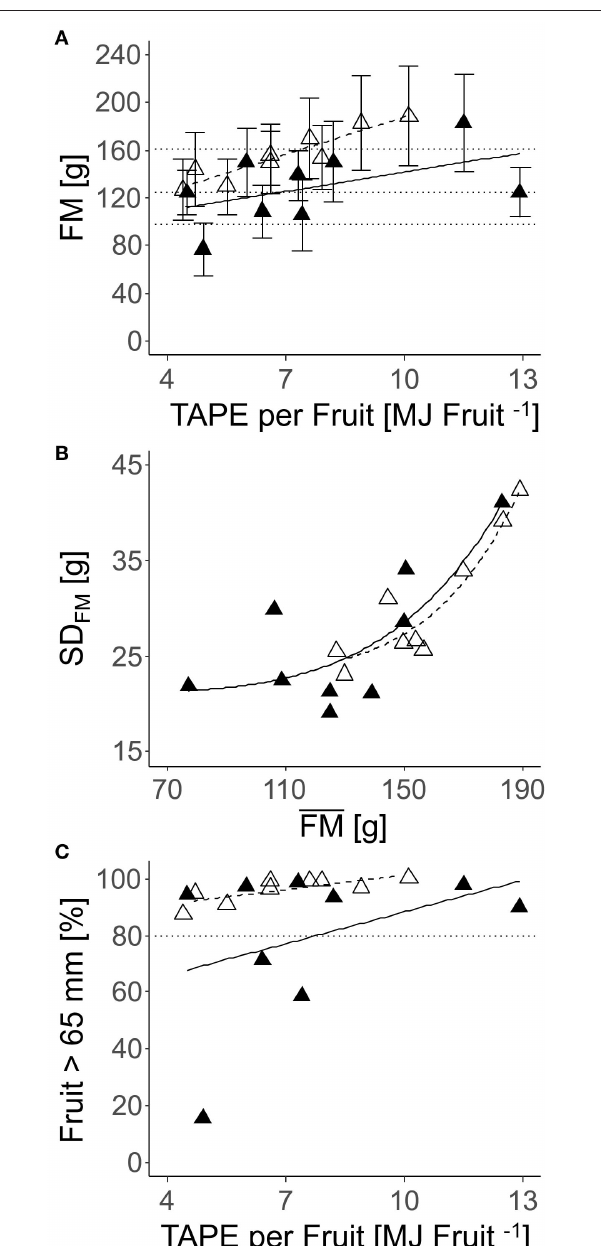
FIGURE 10 | Relationships between FM (mean ± SD ) per tree ( n = 9) harvested completely and the number of fruit per TAPE per fruit (TAPE* fruit − 1